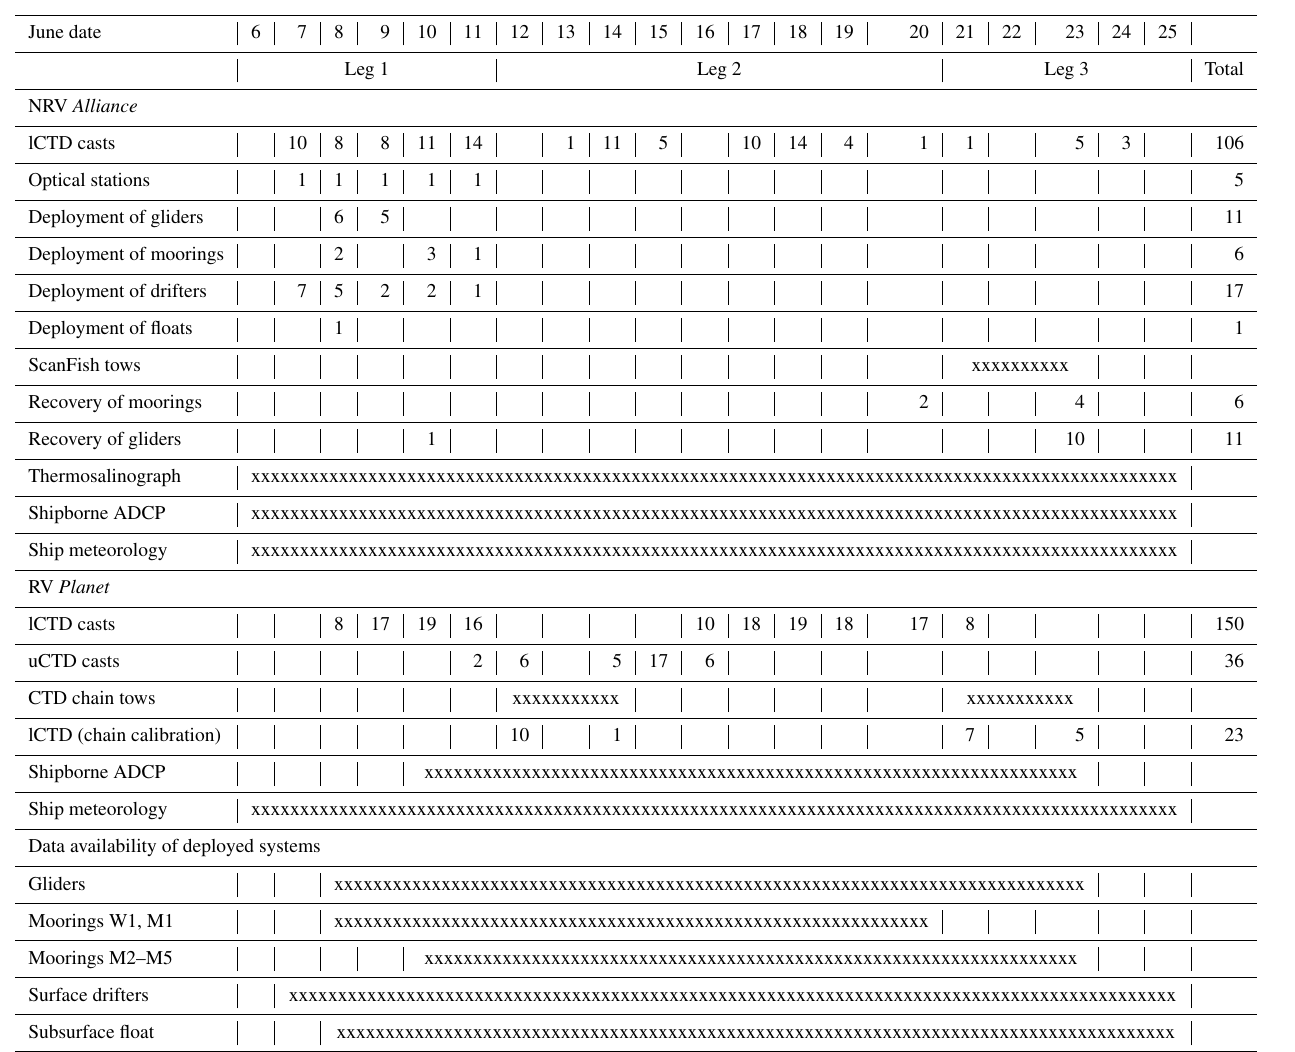
Table 5. The observation schedules of Alliance and Planet and data availability of deployed systems. Sequences of “x” indicate continuous